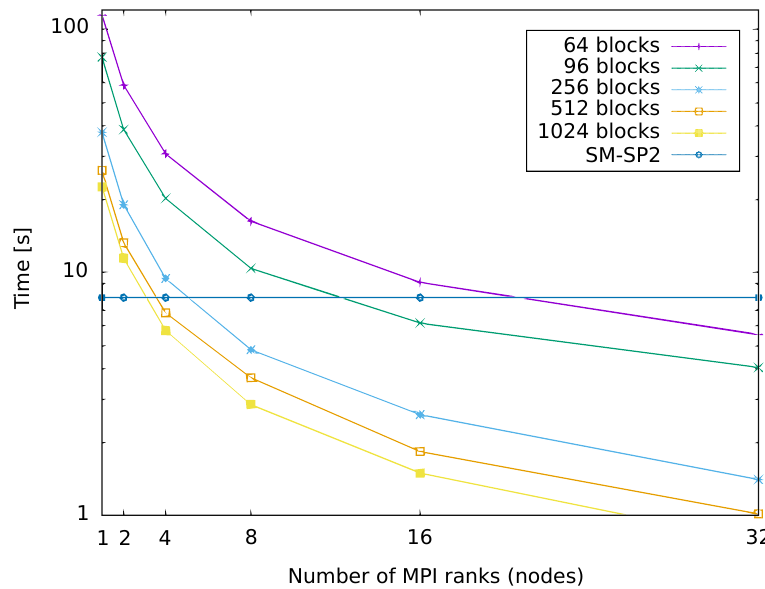
Figure 8. Runtime of parallelized G-SP2 as a function of the number of nodes. Different numbers of blocks. G-SP2 applied to the polyalanine 259 molecule. Figure taken from [12]. Copyright c (cid:13) 2016 Society for Industrial and Applied Mathematics. Reprinted with permission. All rights